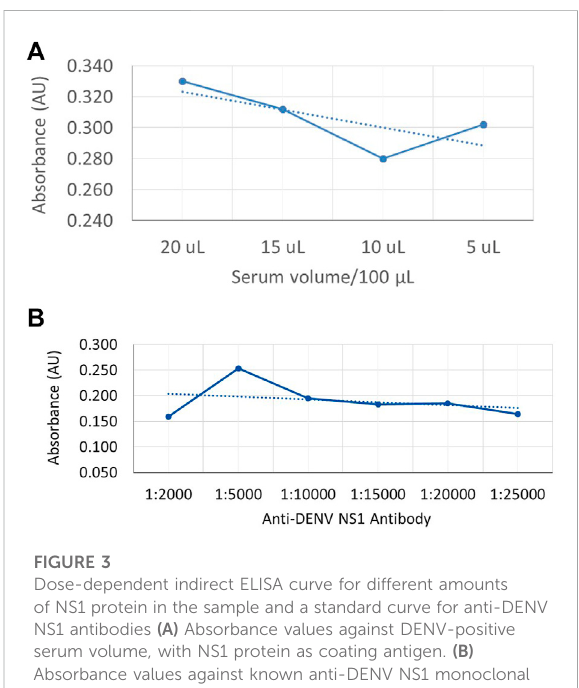
FIGURE 3 Dose-dependent indirect ELISA curve for different amounts of NS1 protein in the sample and a standard curve for anti-DENV NS1 antibodies (A) Absorbance values against DENV-positive serum volume, with NS1 protein as coating antigen. (B) Absorbance values against known anti-DENV NS1 monoclonal antibody concentration as the capture